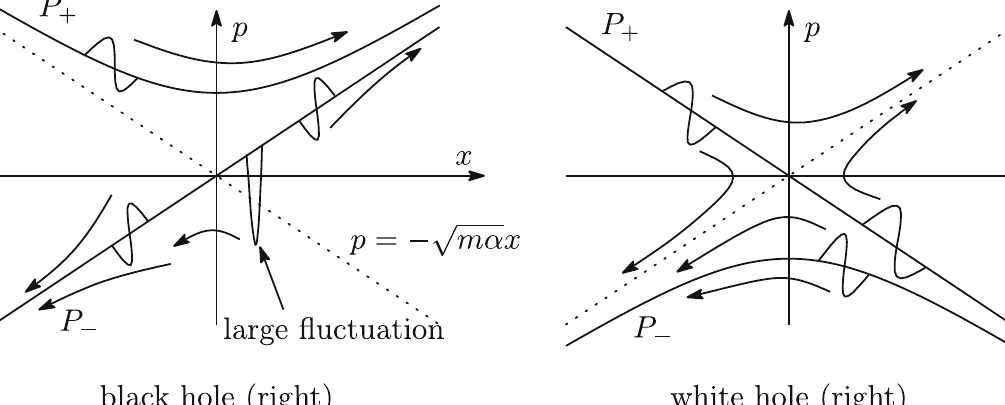
in the supersonic region ( x > 0) cannot propagate into the subsonic region ( x < 0). However, large fluctuations which cross the separatrix −√ p = m α x can propagate. In the white hole case, even small fluc- tuations on P + in the subsonic region ( x < 0) can propagate into the supersonic region ( x > 0). It means that the “causality” of the acoustic white hole is unstable against perturbations on P +